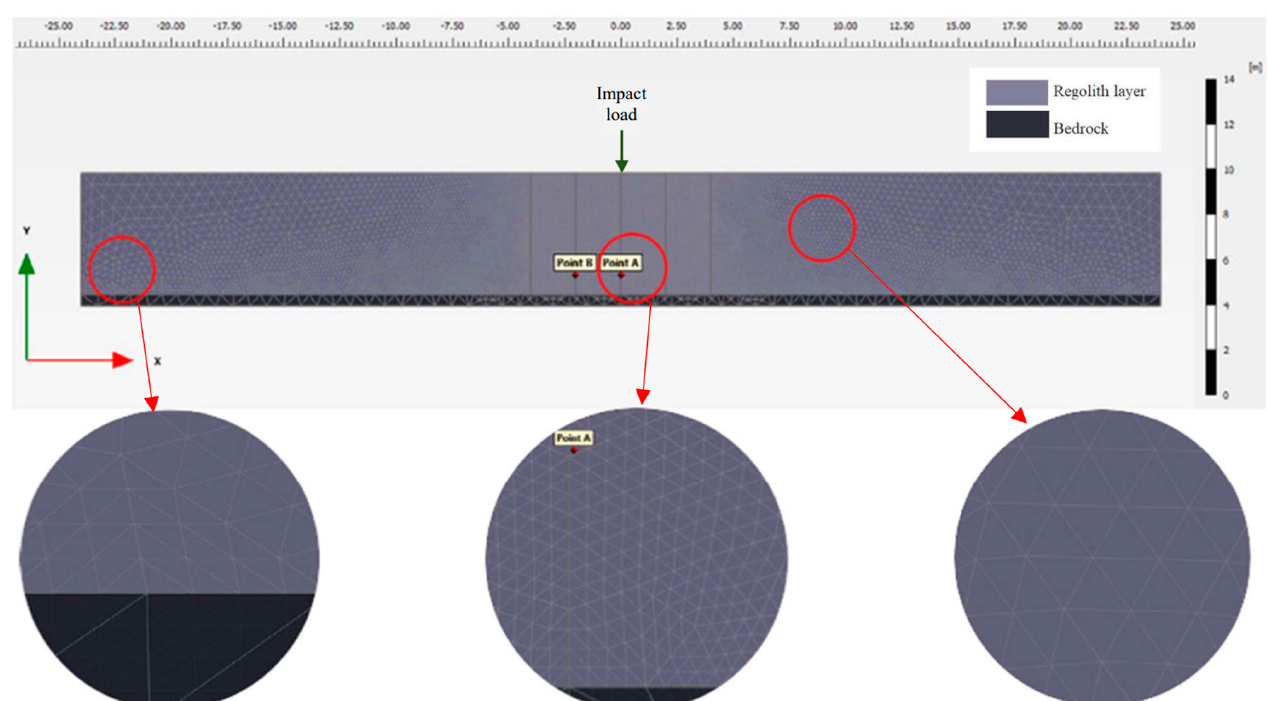
Figure 4. Geometrical model with mesh, punctual impact force and observation points (point A is on the loading vertical, point B is 2 meters from point A, at the same depth; “Bedrock” in the legend is the 50 cm thick layer below the regolith cover). Table 2. Geotechnical parameters of the regolith layer employed in the FEM